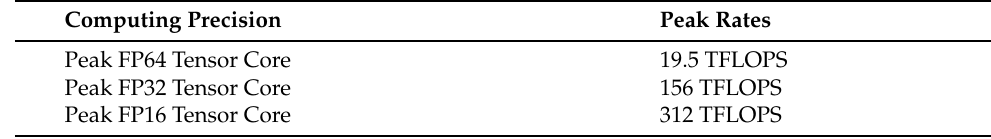
Table 2. NVIDIA A100 Tensor Core GPU performance